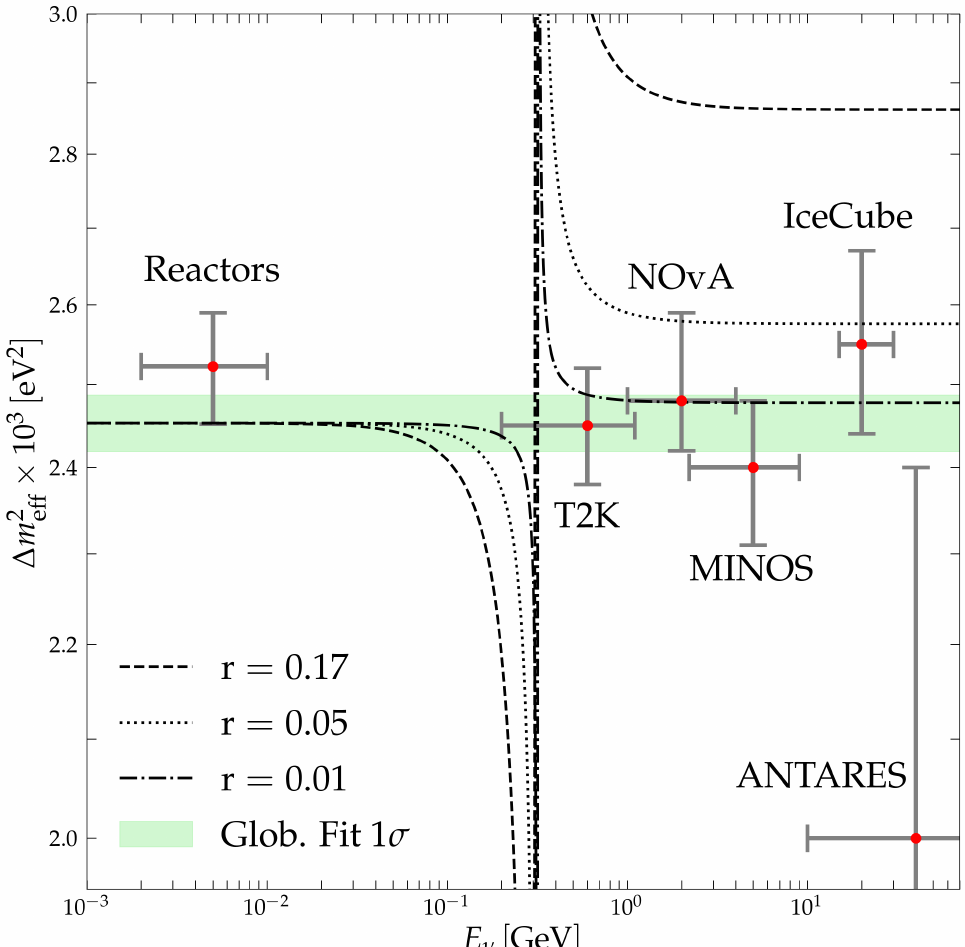
from the global fit of all 32 , ∆ m 2 32 31